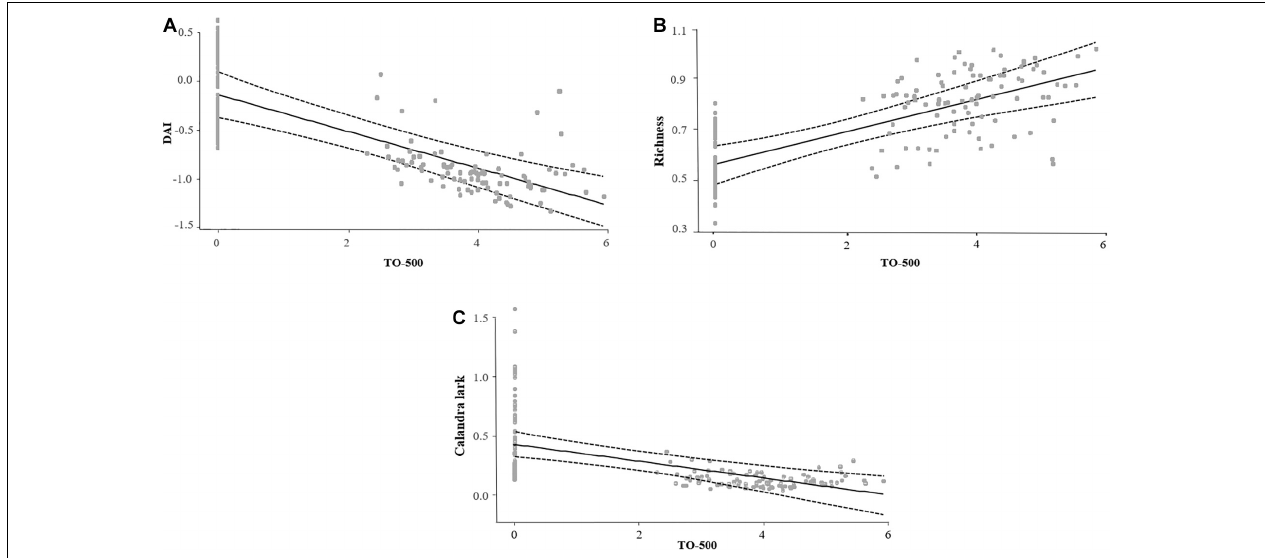
FIGURE 2 | Relationship between model’s predicted values of (A) the dryland affinity index (DAI), (B) species richness, and (C) Calandra lark abundance and the log transformed area (ha) of irrigated orchards up to 500 m (TO-500) around transects. Mean (solid line) and CI (dashed line) of predicted values are shown.